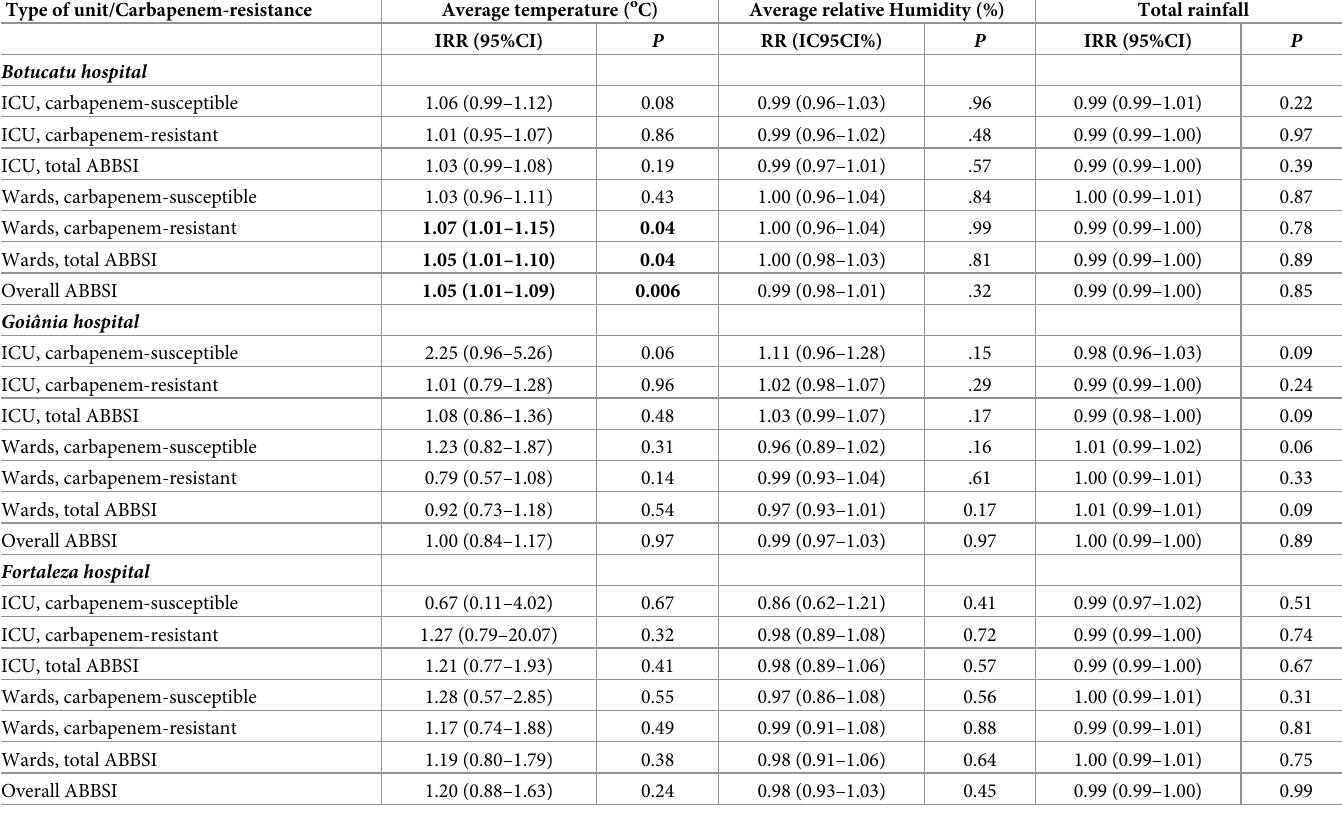
Table 4. Poisson regression analysis of the impact of weather on monthly incidence of Acinetobacter baumannii complex bloodstream infections, according to type of hospital unit and resistance. Type of